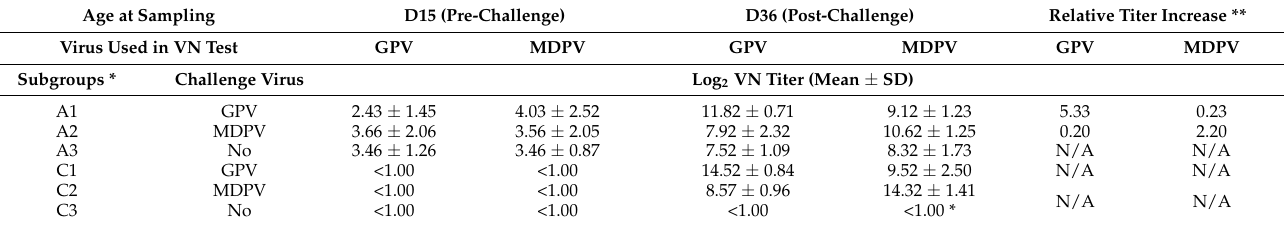
Table 6. Antibody response of vaccinated and non-vaccinated MDA-free Muscovy ducks to challenge infection (log 2 VN titer).